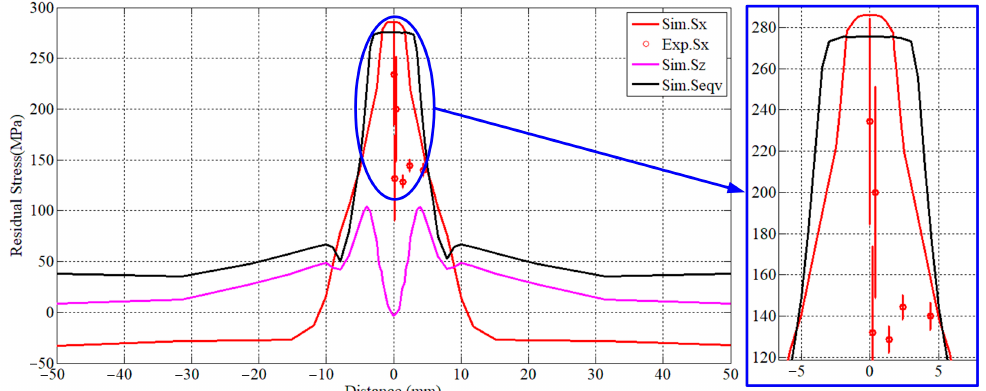
Figure 13. Residual stress along L1.